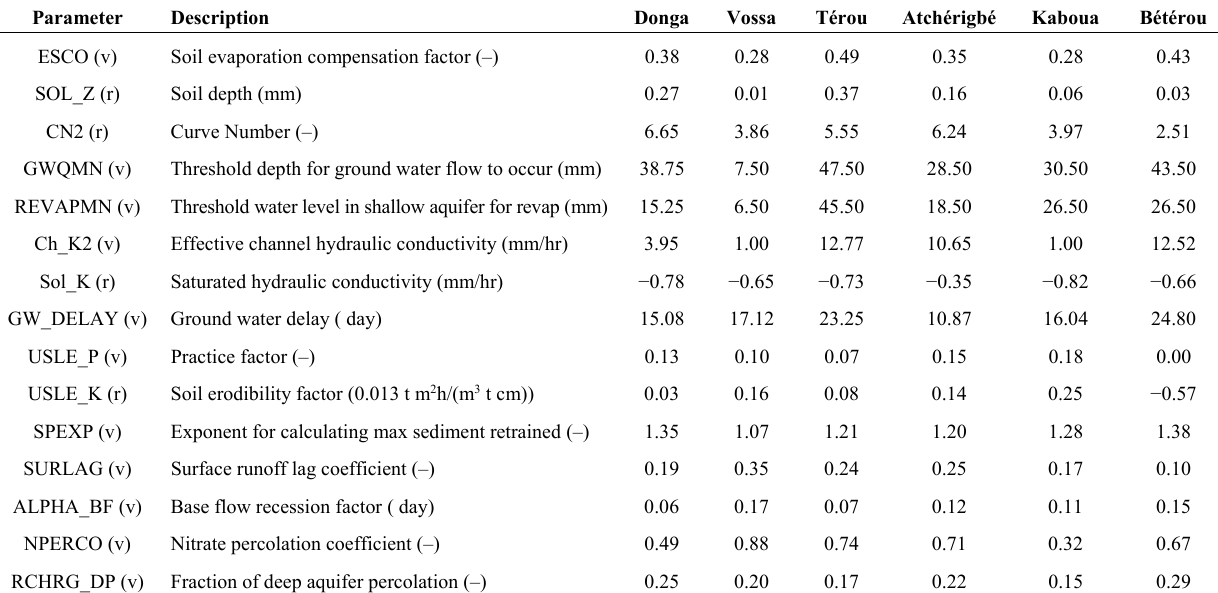
Table 4. Calibrated model parameter matrix involved in the multiple regression analysis. The letters v, r and a mean values, relative change and absolute change, respectively. CN2: SCS Curve Number, ALPHA_BF: base flow recession constant; SOL_K: soil hydraulic conductivity, RCHRG_DP: aquifer percolation coefficient, GWQMN: minimum water level for base flow generation, REVAPMN: threshold water level in a shallow aquifer